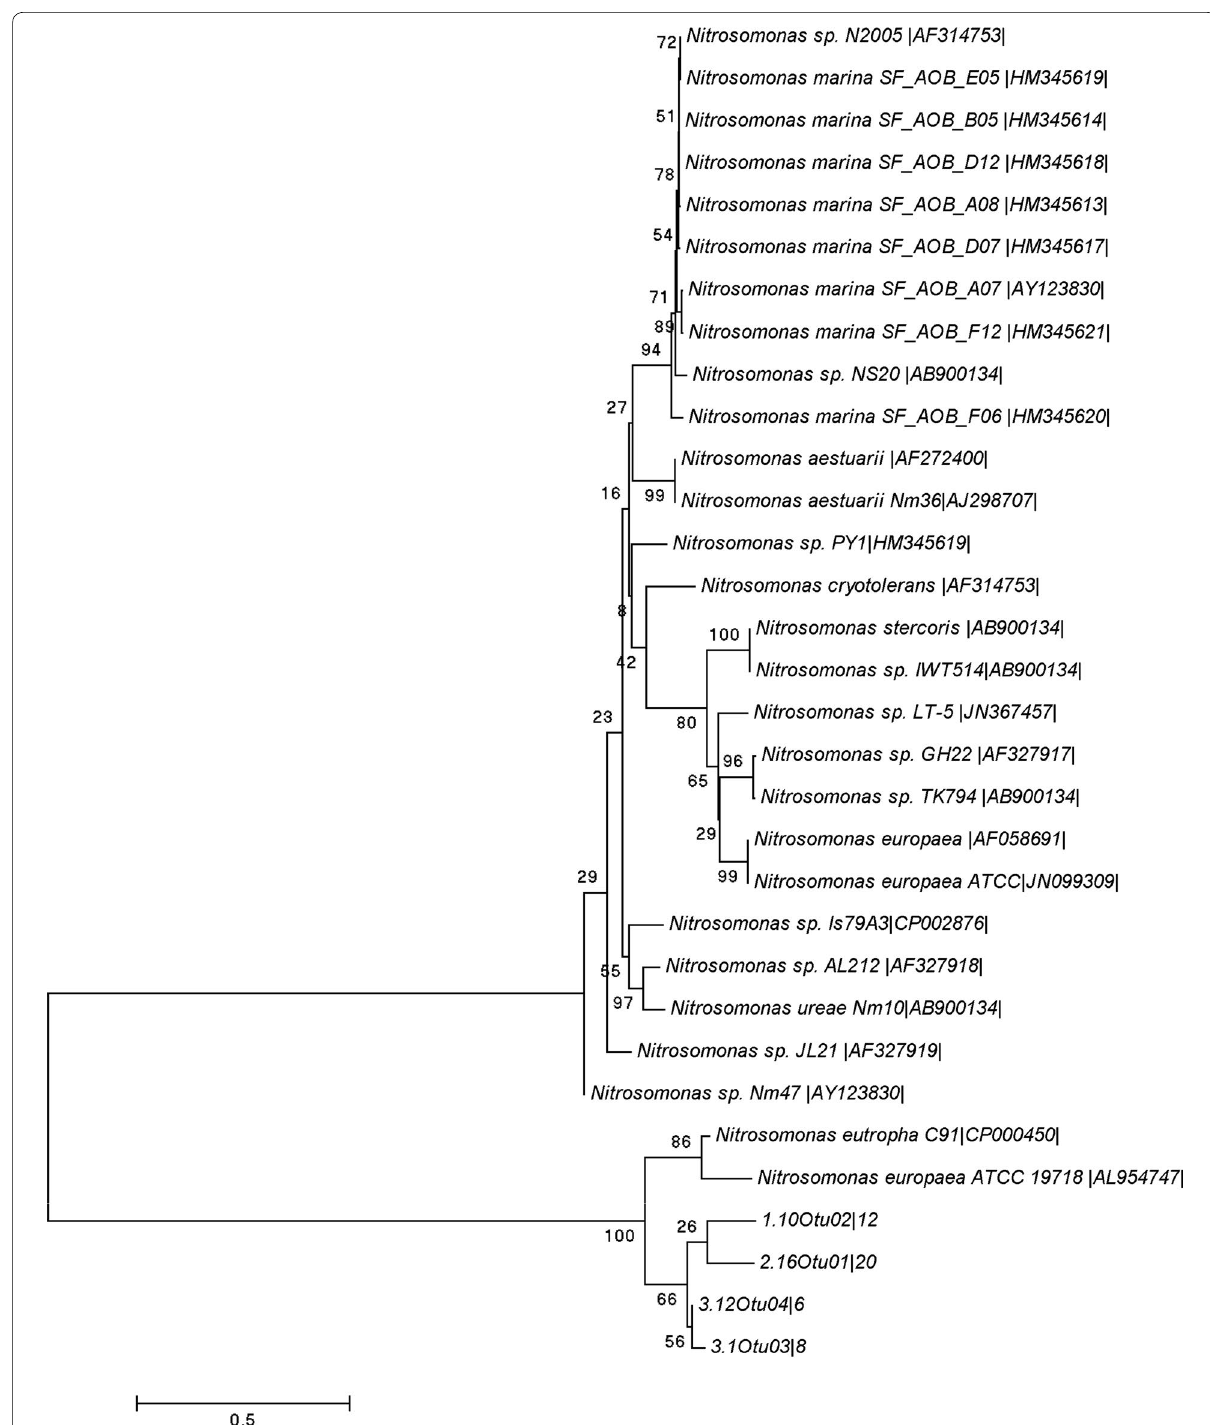
Fig. 2 Neighbor-joining tree for DNA sequences of amoA genes of ammonia-oxidizing bacteria in recirculating aquaculture systems producing hybrid grouper. Numbers to left of nodes indicate bootstrap support for those nodes. The bar shows phylogenetic distance in numbers of nucleo- tide substitutions per